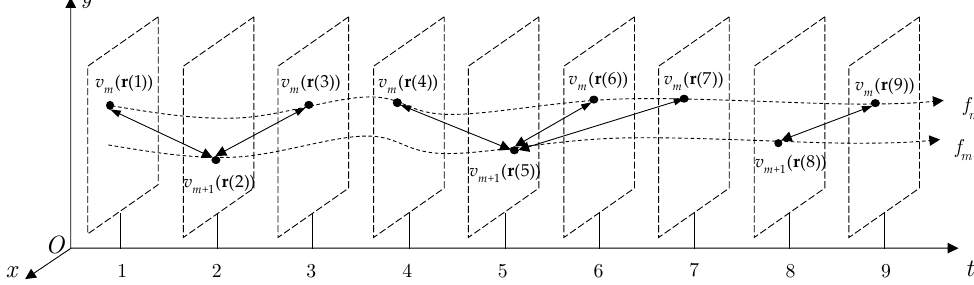
Figure 5. An example to illustrate the pairwise similarity model.